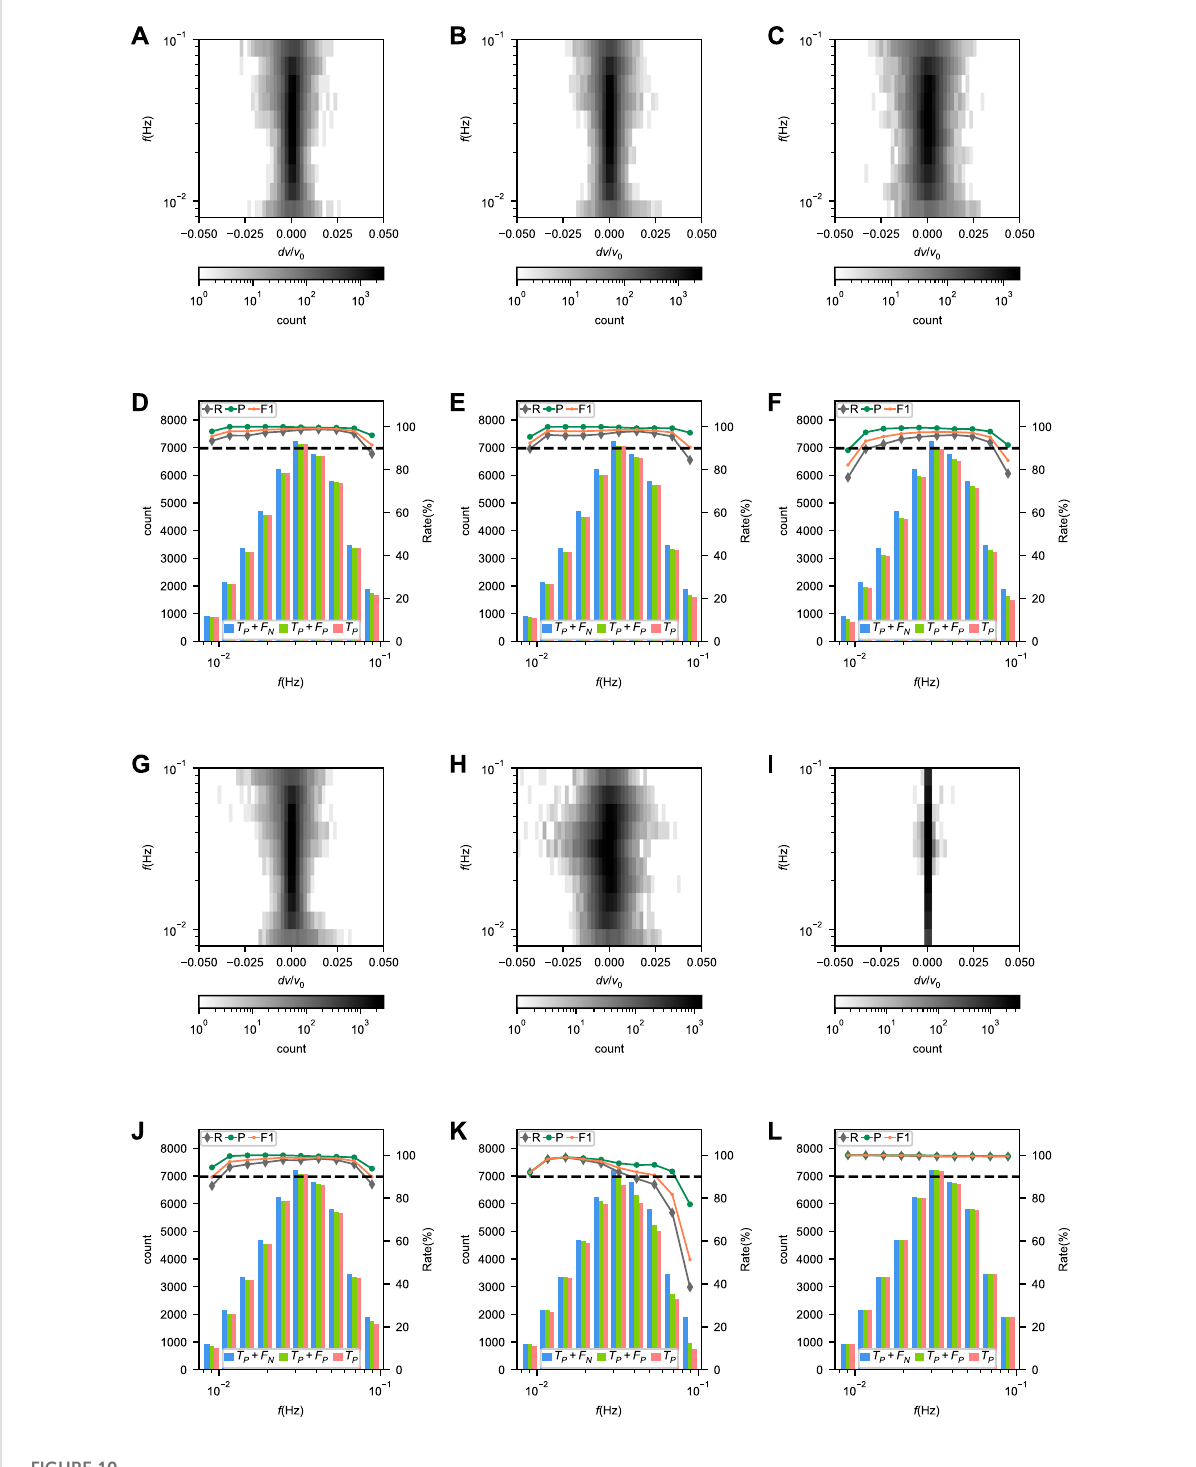
FIGURE 10 (A – C) and (G – I) Error distributions and (D – F) and (J – L) performances of Surf-Net (A,D) , Surf-Net_noDis (B,E) , Surf-Net_small (C,F) , Surf- Net_obs (G,J) , surf-Net_syn (H,K) and the conventional method (I and L) at different frequencies for the single picks in the observational test